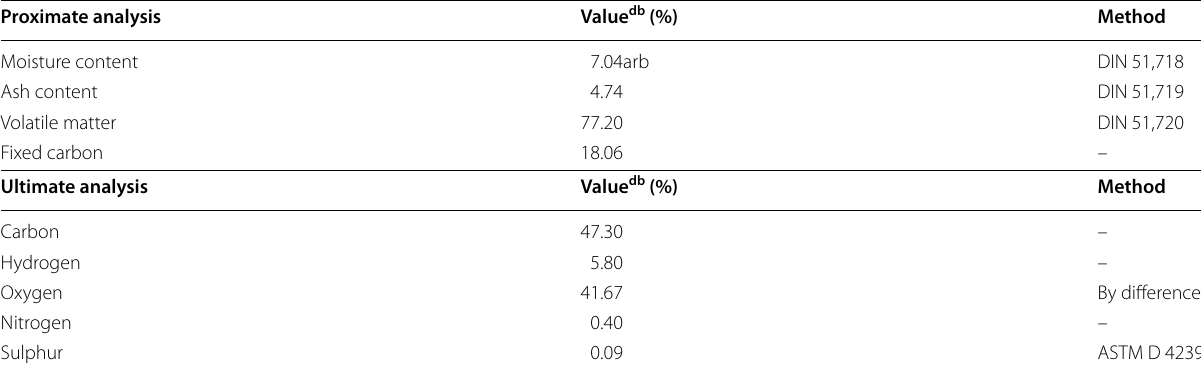
Table 1 Proximate and ultimate characteristics of sweet sorghum (Wilen et al. 1996) Proximate